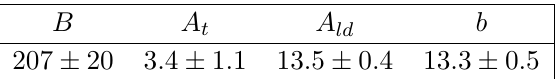
Table 9 . Input values (in MeV) for the couplings required for the mass estimations of the P -wave pentaquarks. For the coupling B , the error is taken from